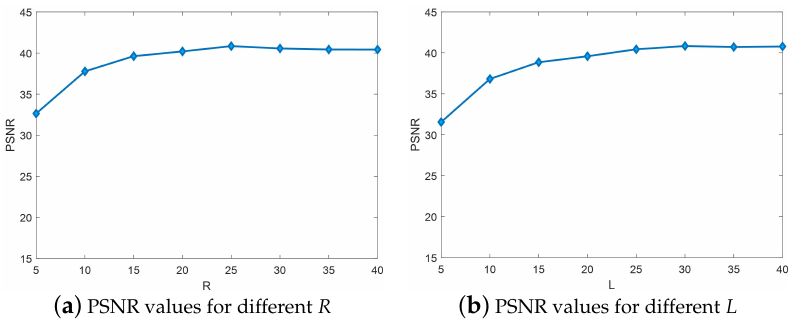
Figure 6. ( a , b ) PSNR values for different R and L in the Pavia University dataset.